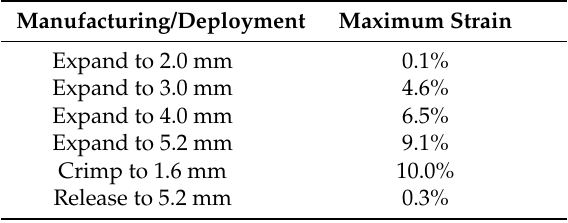
Figure 9. Contour plots of strain distribution ( a ) at crimping and ( b ) after release into an artery. Table 1. Maximum strain occurring during the manufacturing and deployment